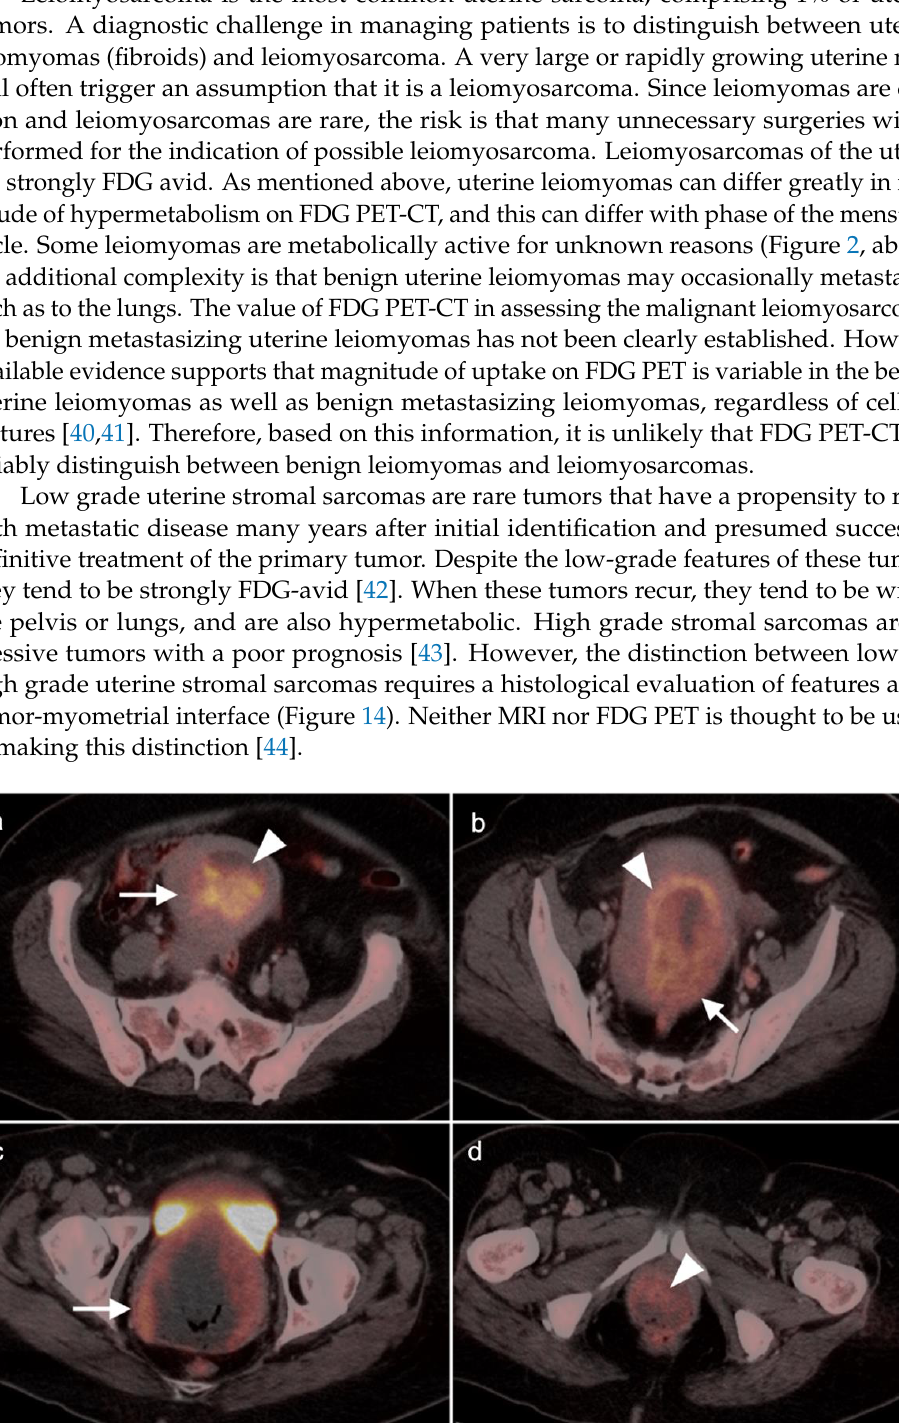
Figure 14. Endometrial stromal sarcoma on axial FDG PET-CT images of the pelvis. ( a , b ) A hy- permetabolic endometrial mass fills the endometrial cavity (white arrowheads) and is centrally necrotic. ( c , d ) There are multiple areas of myometrial invasion (white arrows). Histologically, this was a high-grade endometrial stromal